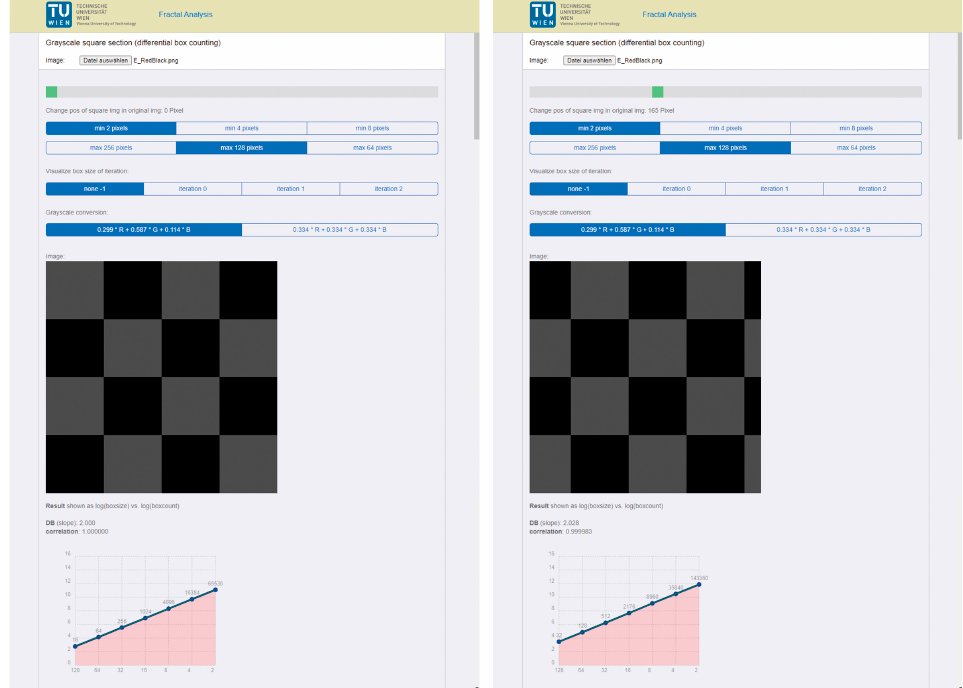
Figure 7. Checkerboard measurement with the “Grayscale DBX M × M ( m × m )” method. ( Left ): Image section with a matching grid ( 𝐷 (cid:3003) = 2 with a correlation of 1.0). ( Right ): Image section that was moved relative to the grid ( 𝐷 (cid:3003) = 2.028 with a correlation of 0.999983).